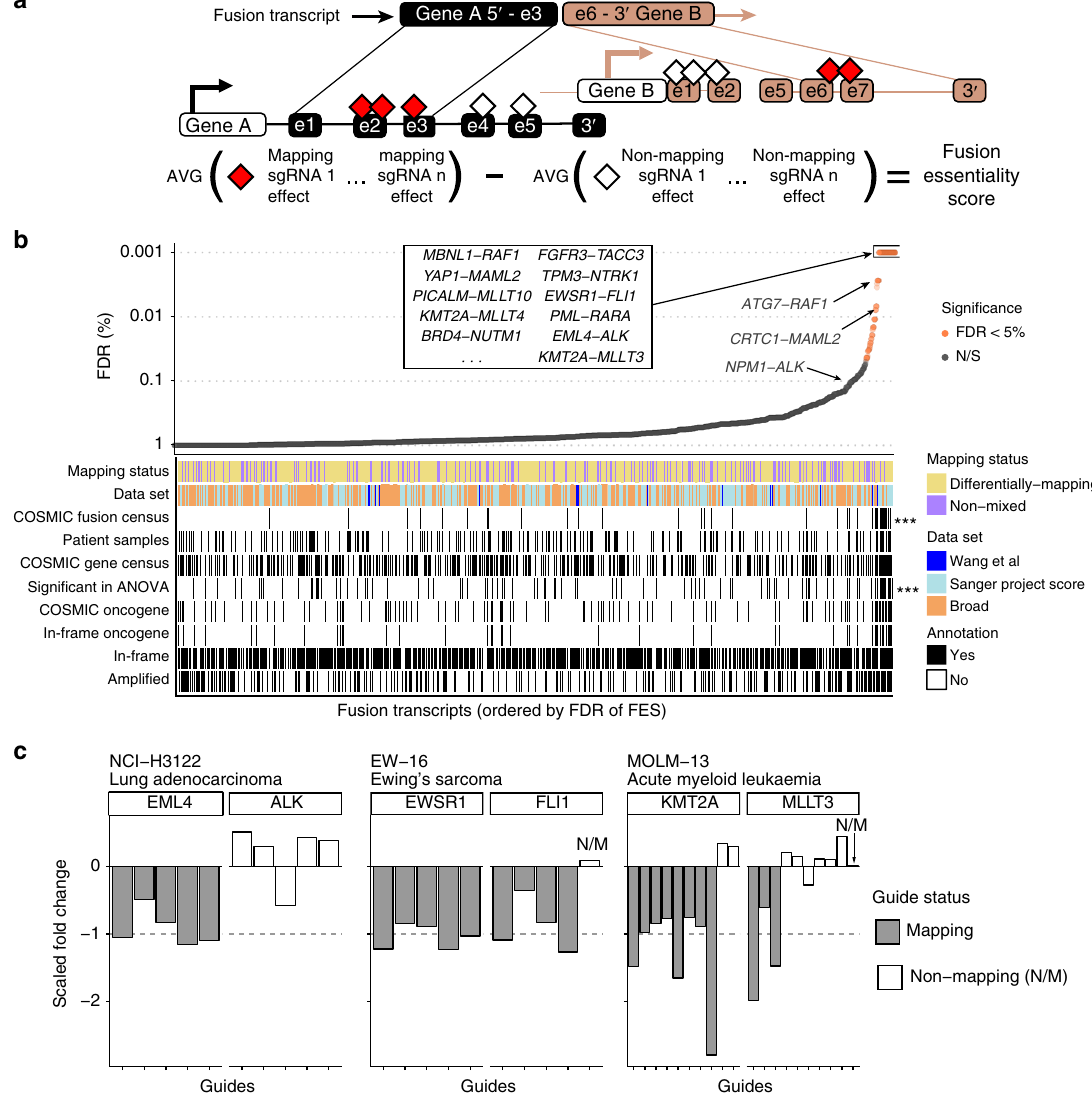
Fig. 4 CRISPR screening data identi fi es functional fusions. a Calculation of fusion essentiality scores (FES) by measuring the differential fi tness effect of mapping vs. non-mapping single guide RNAs (sgRNAs) to each gene in a fusion transcript. b False discovery rate (FDR) of FES scores for all testable fusion transcripts ( n = 2821). Transcripts with at least one mapping and one non-mapping guide are “ differentially mapping, ” while transcripts with only mapping guides are “ non-mixed ” . Fusion transcripts were classi fi ed into the indicated genes sets and p values were calculated using gene-set enrichment analysis (GSEA). Selected known oncogenic fusions and other fusions of interest are labeled. c Examples of functional fusion transcripts identi fi ed in speci fi c cancer cell lines based on FES scoring. Each bar is the scaled fold change of an individual sgRNA to fusion 5 ′ and 3 ′ end partner genes, and colored by fusion mapping or non-mapping sgRNA. Dashed line is at − 1 (to which known essential guides were scaled). AVG = average; N/S = not signi fi cant at 5%